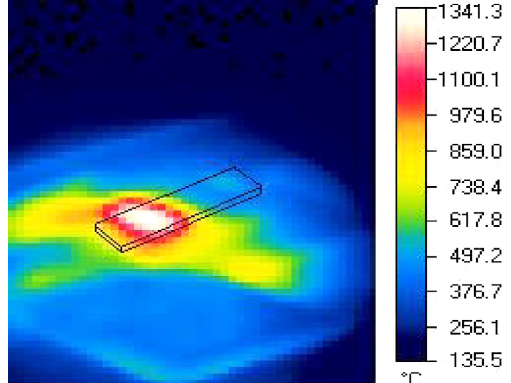
Fig. 2. Infrared imaging of temperature variation during laser annealing. The sample is schematically indicated as a rectan- gular object.